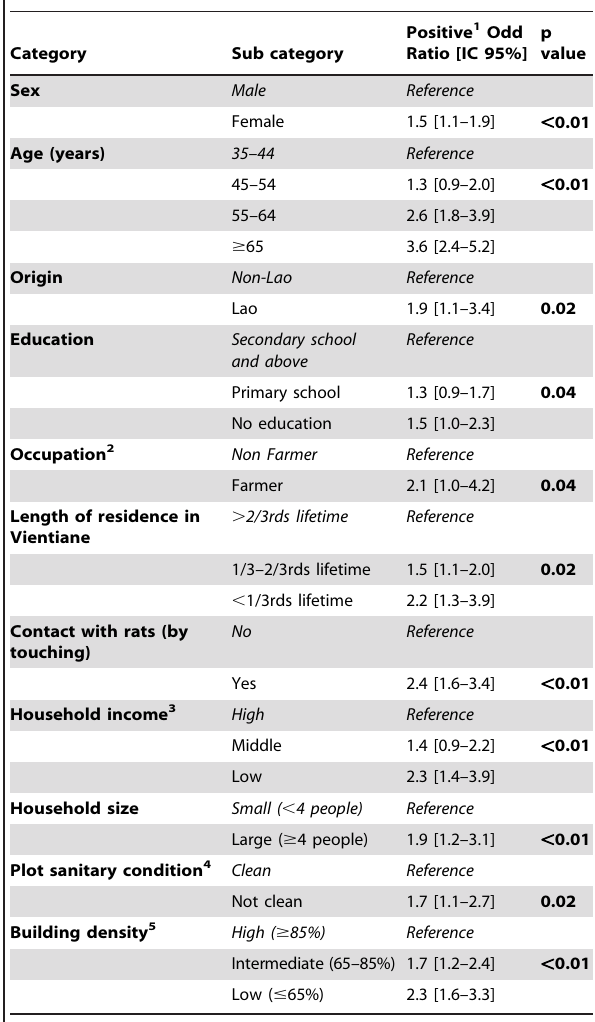
Table 4. Multivariate logistic regression analysis of factors associated with IgG positivity against scrub typhus (Vientiane city, 2006).